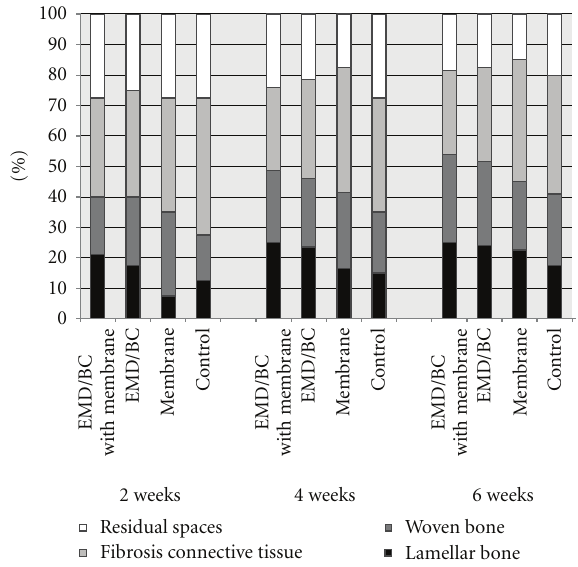
Figure 3: The mean percentages of lamellar bone, woven bone, and fibrous connective tissue for each experimental group and time interval. EMD/BC + M: EMD/BC with membrane; EMD/BC: EMD/BC without membrane; M: membrane only; C: control. Table 2: OPN staining intensity in each experimental group. Staining Treatment group